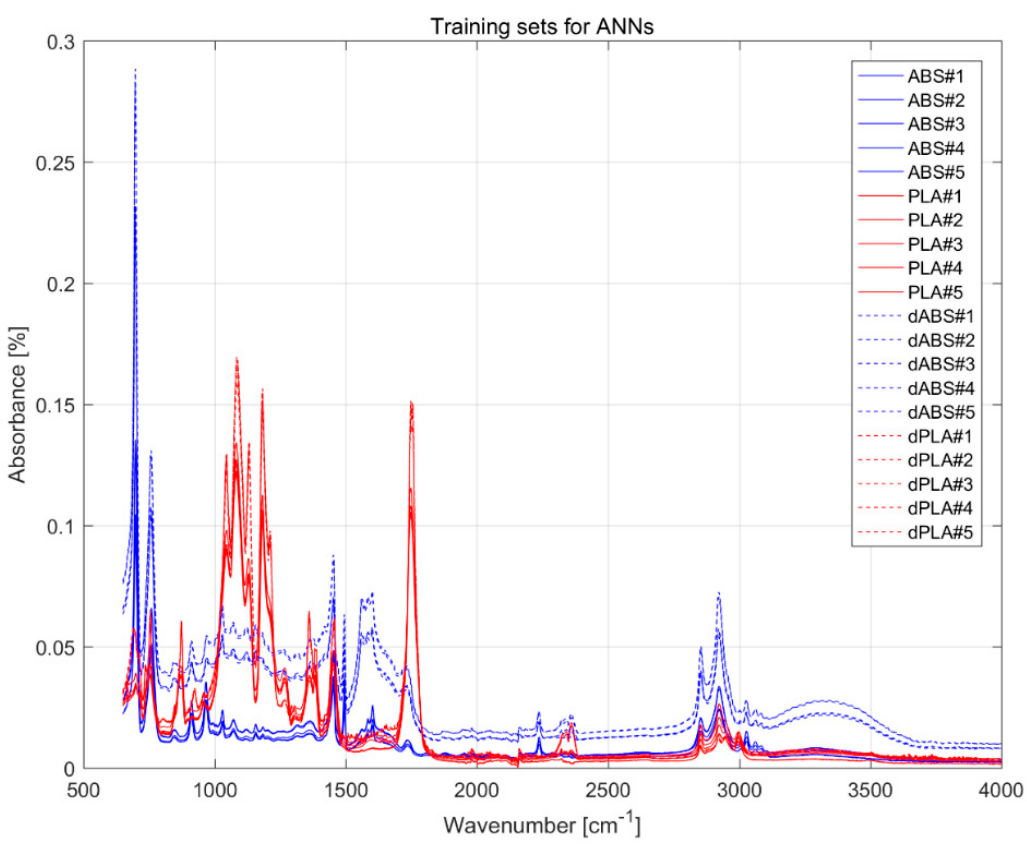
Figure 8. Twenty training sets for ANNs.